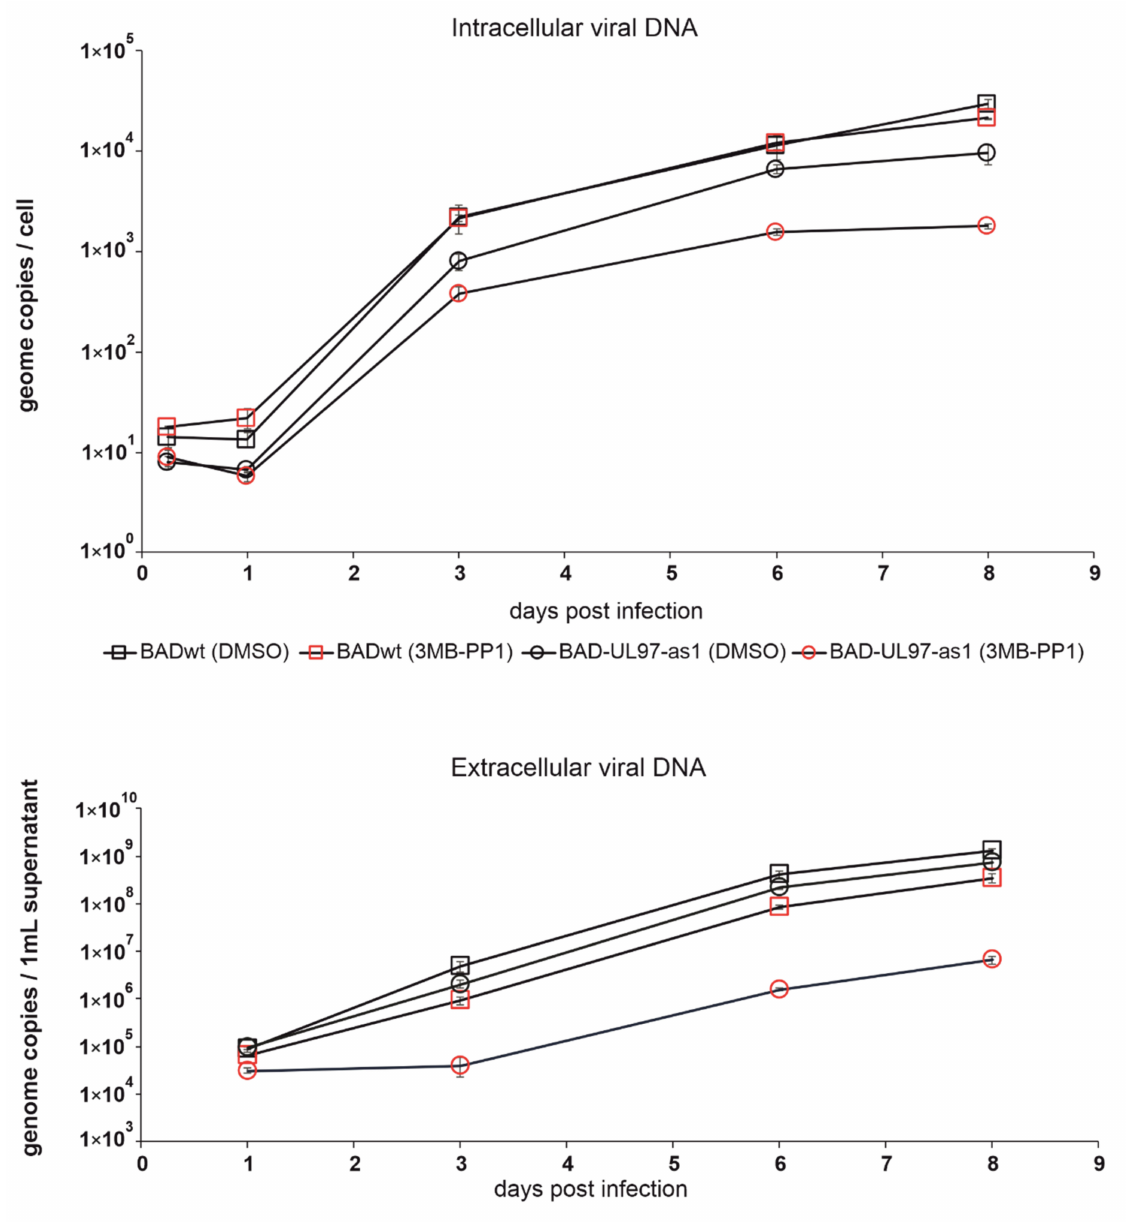
Figure 3. Replication kinetics of BADwt and BAD-UL97-as1 after treatment with 3MB-PP1. Cells were treated with either 40 µ M of 3MB-PP1 or with DMSO one day before infection. The next day, cells were infected with BADwt or BAD-UL97-as1 with 4 genomes/cell. Samples were taken and viral DNA was extracted from infected cells and the cell supernatant at the indicated time points. The intracellular and extracellular viral genome copies were quantified by quantitative PCR